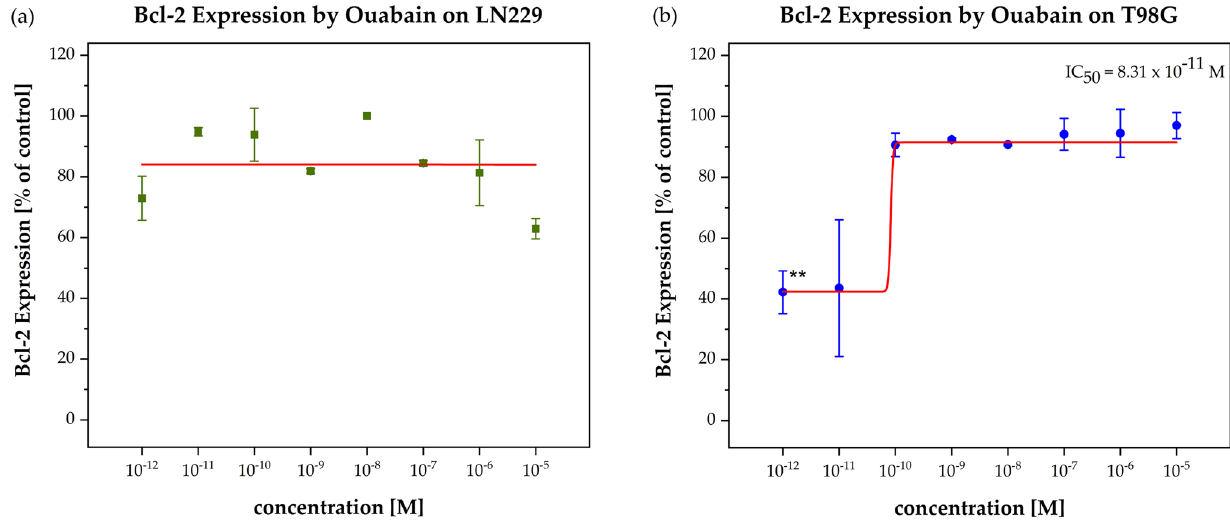
Fig. 5 Bcl-2 Down-regulation of Bcl-2 expression in cell line LN229 ( a ) and T98G ( b ). The Bcl-2 expression (% of control) was plotted as the function of the Ouabain concentration (10 –12 to 10 –5 M) after 24 h treatment. OD450-540-values of cell lysates measured in 1:5 dilution in the Bcl-2 ELISA-kit are presented. The red curves represent the nonlinear regression analysis for the IC Bcl-2 expression was only observed for the TMZ-resistant cell line T98G by IC ues of each duplicate and the level of significance is shown by the p-value range ( ** p < 0.01)